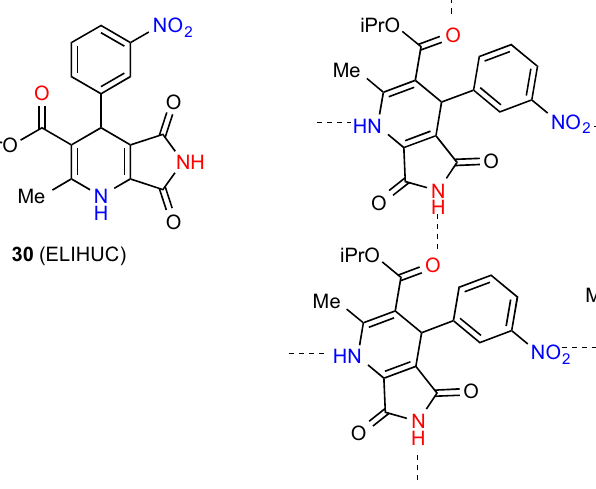
Figure 11. Structure adopted by compound 30.